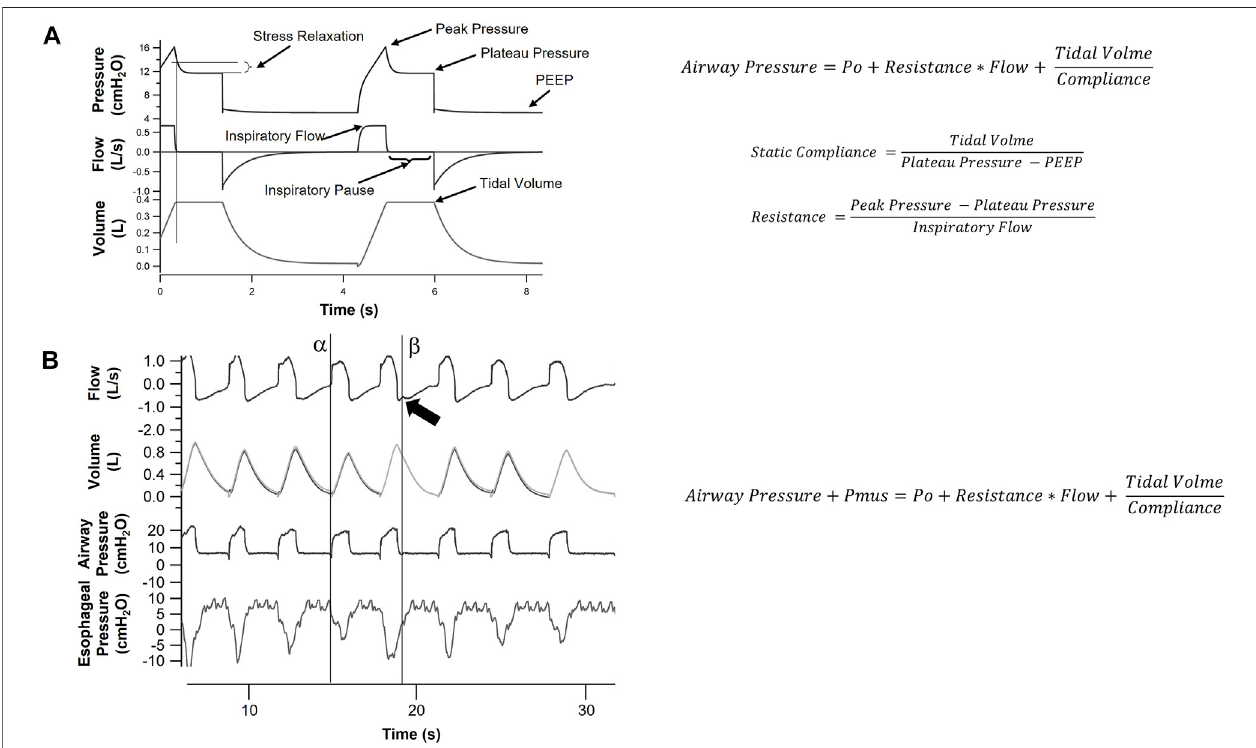
FIGURE2| Respiratorymechanicsinparalyzedandspontaneouslybreathingpatients. (A) .ThisisarepresentationofFlow,VolumeandPressuresignalsovertime for a patient under sedation and neuromuscular blockage. Since there is no respiratory muscle activity, equation of motion (see Figure 1A ) can be applied. Compliance (inverse of Elastance, displayed in Figure 1 ) and Resistance can be found using minimum square method or by the inspiratory pause special case displayed in (A) . Applying an inspiratory pause will simplify the equation allowing measurement of Static Compliance and Resistance. It also allows observation of viscoelastic properties of the respiratory system, with the slow decrease in pressure (Stress Relaxation) once fl ow is abruptly stopped. (B) . In non-sedated patients, respiratory muscles interact with the ventilator. In this example, we show Pressure, Flow, Volume and Esophageal Pressure signal over time in a patient ventilated in Pressure SupportMode.Muscleactivitycanbemeasuredwithanesophagealcatheter.Inthisscenario,equationofmotionneedstobeadaptedtoincludepressuregeneratedby respiratory muscles (Pmus). The model becomes less stable but esophageal pressure reveals several features of patient ventilator interaction. The observed changes in tidalvolumesoverseveralbreathsiscausedbyachangeinpatient ’ seffortdetectedbyesophagealpressure.Additionally,wecanobservetheinspiratoryefforttriggering mechanical ventilator (line α ) and the prolongation of patient ’ s inspiratory effort into ventilator expiration (line β ), distorting expiratory fl ow curve (arrow).